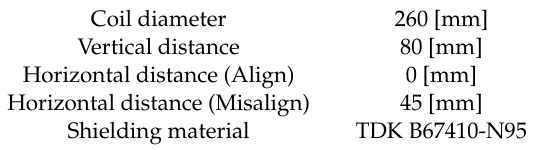
Table 3. Description of resonator